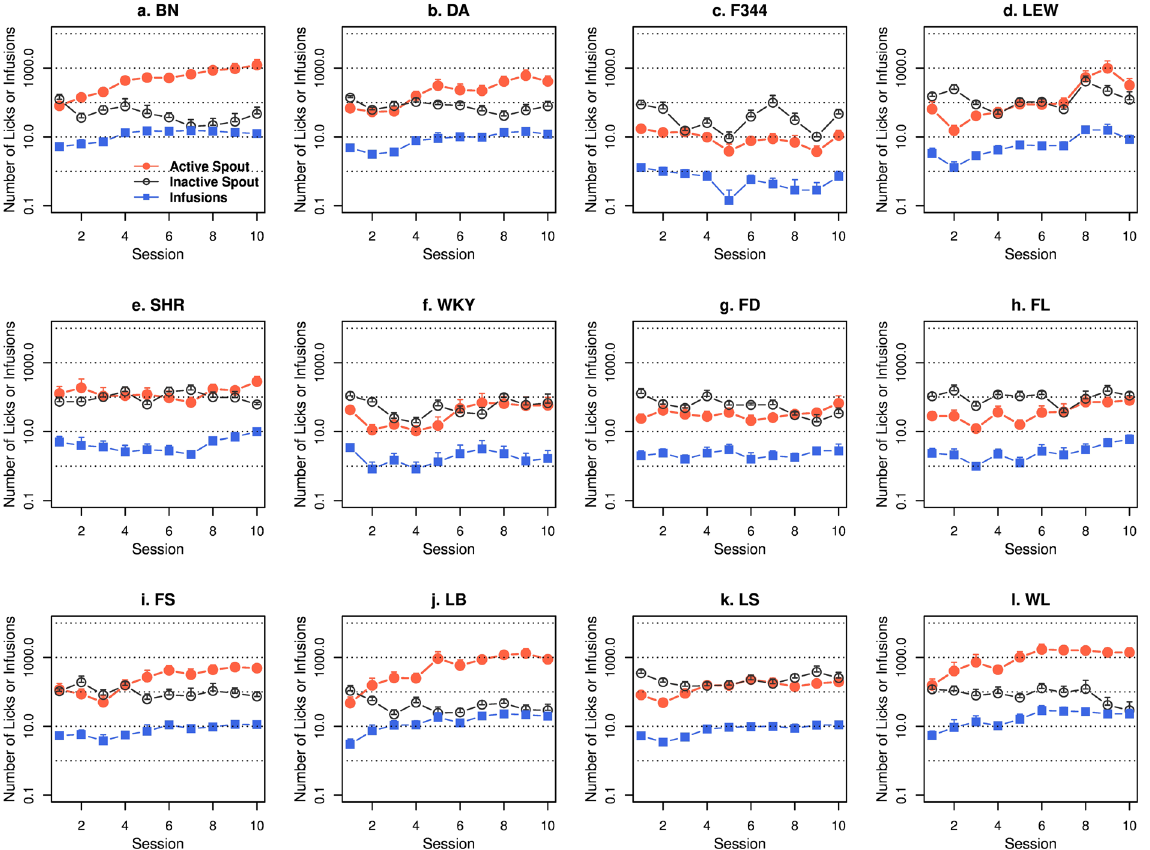
Figure 2. Female adolescent rats from 12 isogenic strains were tested by using the socially acquired nicotine (30 μ g/kg/inf) IVSA procedure. See Methods for a detailed description of the procedure. The Y-axis used a logarithmic scale.